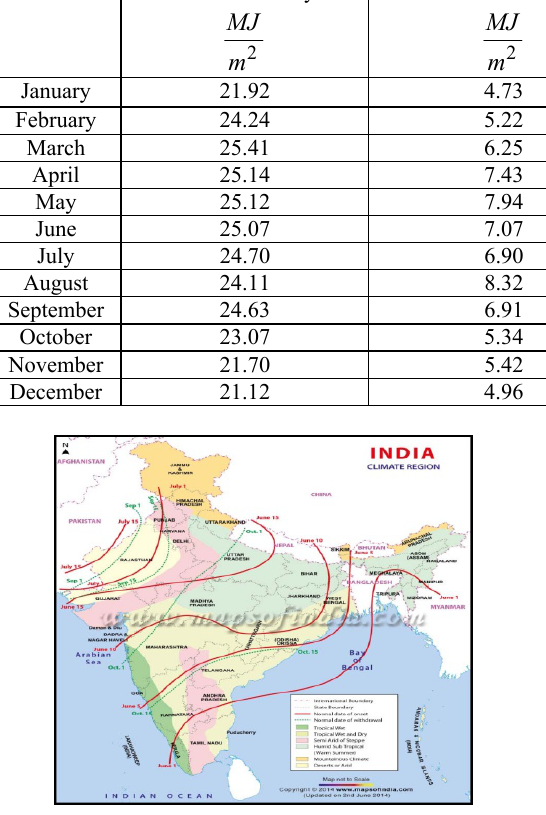
Figure 2. Availability and indication of solar radiation level in India